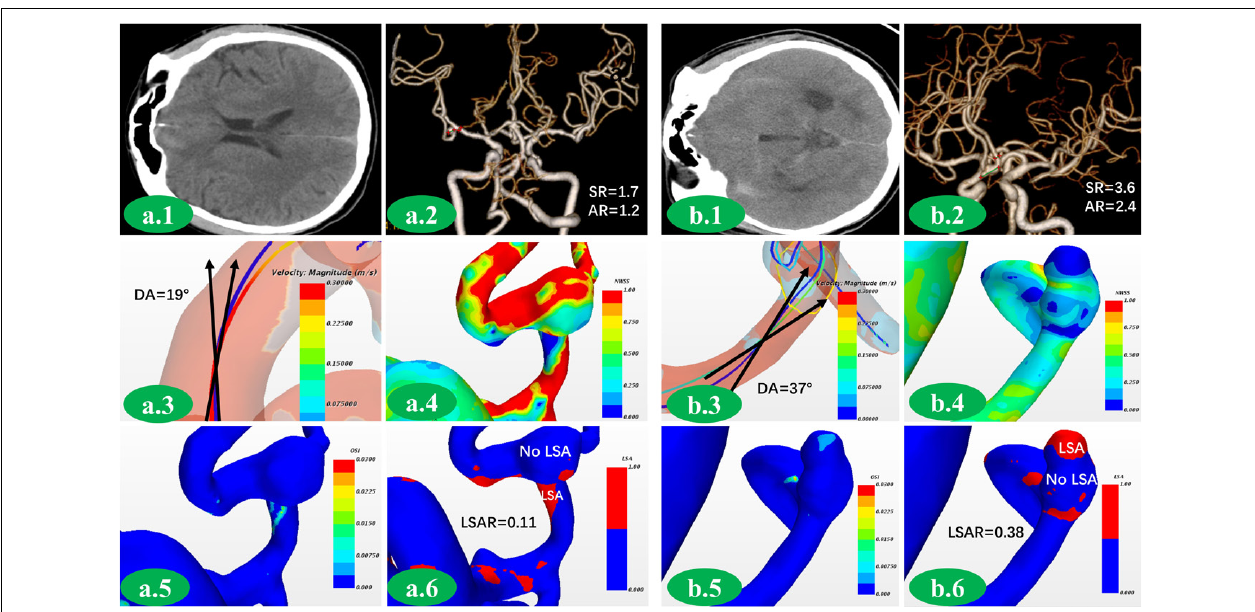
FIGURE 3 | A group of aneurysms with similar match score were presented here. This was an unruptured middle cerebral artery aneurysm (a.1,2) . SR was 1.7. AR was 1.2 (a.2) . DA was 19 ◦ (a.3) . NWSS of aneurysm was close to that of parent artery (a.4) . There was no area with increasing OSI (a.5) . There was no obvious